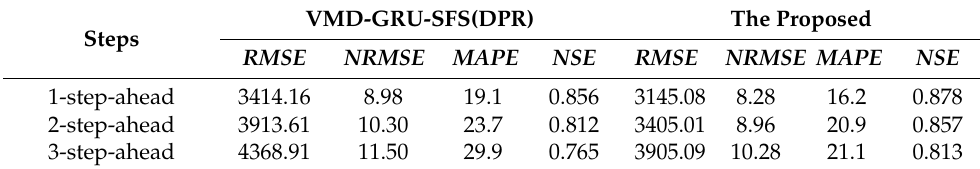
Figure 12. Scatter fitting plots for test sets using VMD-GRU-SFS (DPR) and the proposed method for 1, 2 and 3-step ahead forecast at Yichang station. ( a ) VMD-GRU-SFS (DPR) model ; ( b ) The proposed method. Table 5. Results of different forecasting methods for the Yichang station.